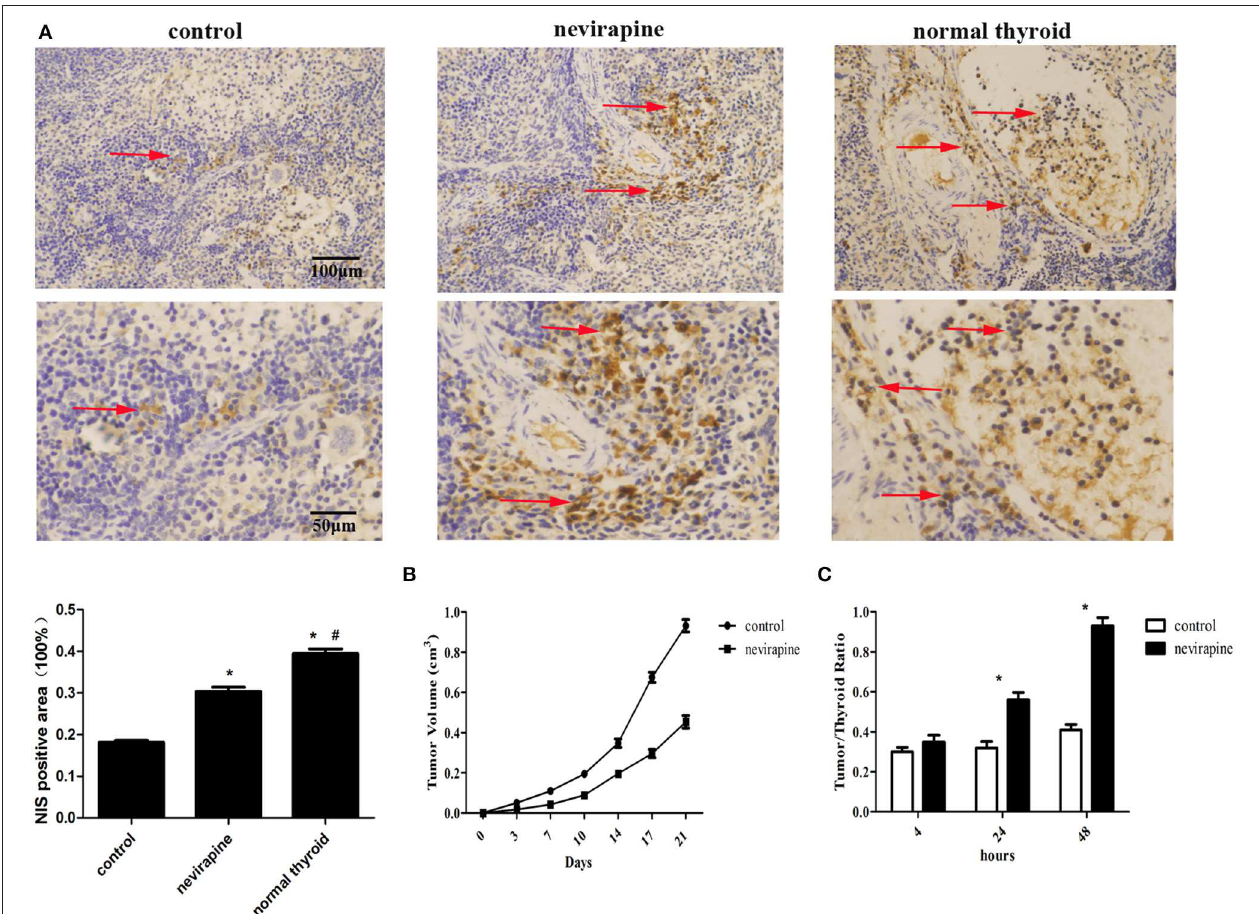
FIGURE 6 | Nevirapine inhibited tumor growth and induced NIS protein expression and iodine accumulation in athymic mouse xenografts of WRO 82-1 cells. (A) The expression of NIS in xenografted tumors treated by nevirapine or DMSO (control) and normal human thyroid were detected by immunohistochemical staining and analyzed quantitatively. Arrowheads indicate positive staining areas. (B) The tumor growth in athymic mouse xenografts of WRO 82-1 cells treated by nevirapine or DMSO up to 21 days. (C) RAIU in nude mice treated by nevirapine or DMSO (control) was expressed as a ratio of tumor to nude mouse thyroid. Scale bar represents 100 µ M (upper) and 50 µ M (lower). * P < 0.05 vs. control group, # P < 0.05 vs. nevirapine-treated group.